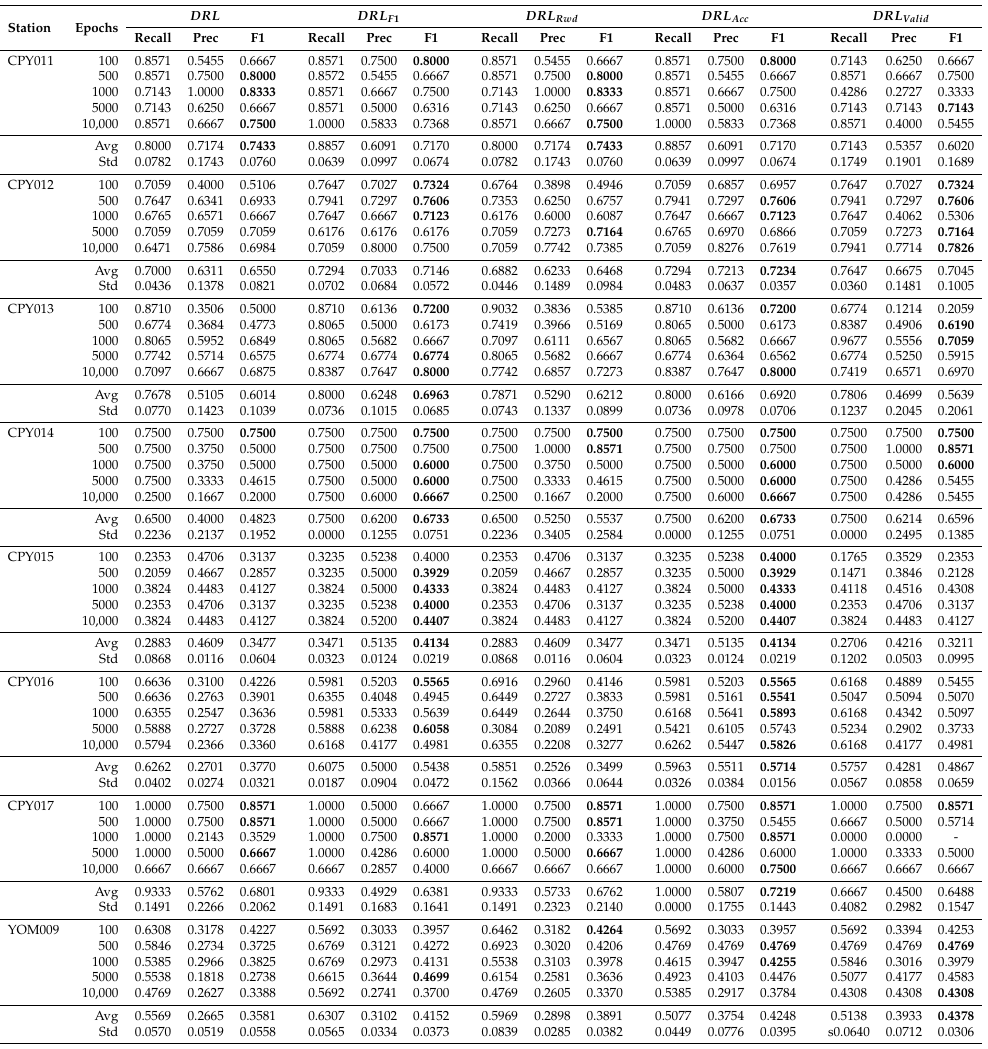
Table 3. The performance of DRL when increasing the learning epochs (the best F1-score of each row shown in